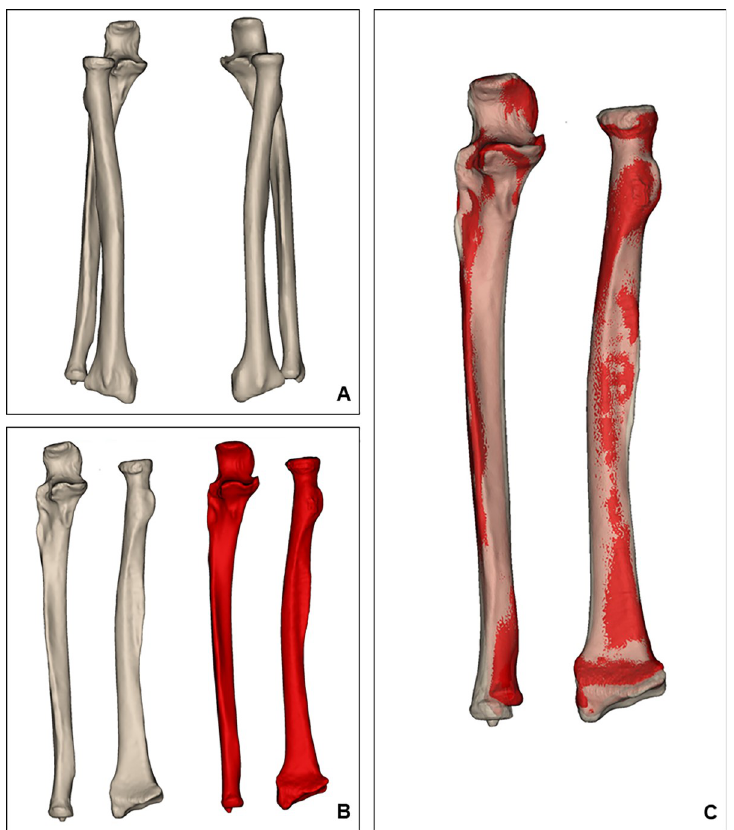
Fig 1. 3D model alignment and model registration process. (A) We imported 3D models of the radius and ulna. (B) The left forearm bones were geometrically reflected, and all forearm bones were aligned to an anatomical coordination system. (C) The radii and ulnae were